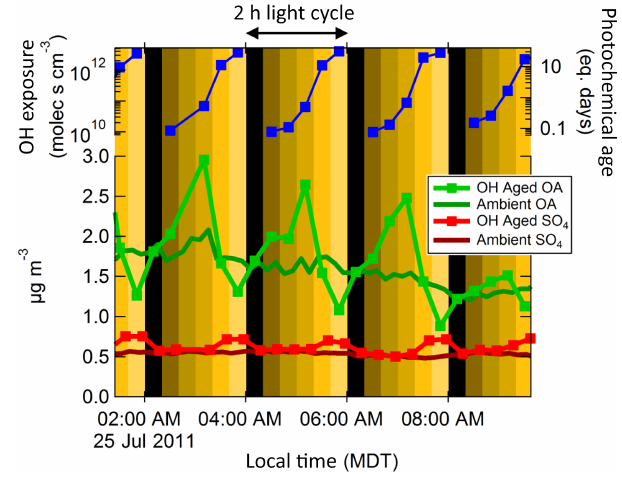
Figure 2. Continuous cycling of OH oxidation using the OFR185 method, compared to concurrent ambient measurements. The saw- tooth pattern in the OFR results from OA mass enhancement at low–intermediate OH exposure (OH exp ) and decreases at the high- est photochemical ages. SO 4 mass increased monotonically with OH exp and at higher exposures, as expected from relatively slow SO 2 + OH oxidation and lack of OH destruction of SO 4